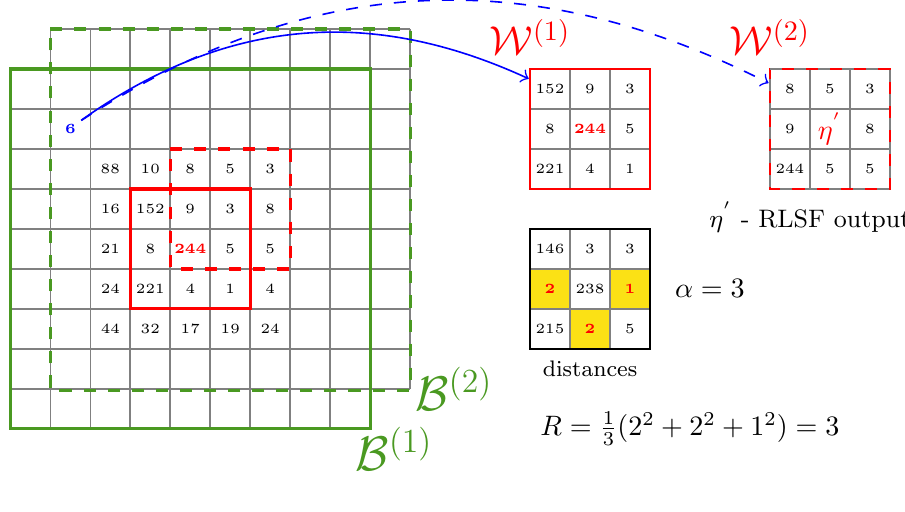
Figure 1. Illustration of two first steps of the Robust Mean Shift